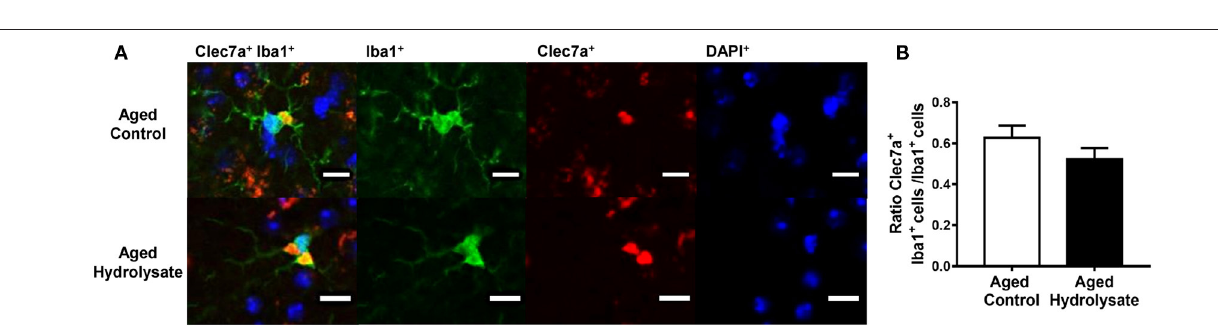
FIGURE 7 | Effects of the fish hydrolysate supplementation on Clec7a + Iba1 + /Iba1 + cells in the hippocampus. (A) Representative images of Clec7a + Iba1 + /Iba1 + cells (double staining), Iba1 + cells (in green), Clec7a + cells (in red) and DAPI + cells (in blue) (scale bars: 10 µ M) and (B) Number of positive cells for Clec7a and Iba1 staining in the hippocampus of aged mice fed with the control diet or the hydrolysate-enriched diet for 10 weeks ( n = 8 per group). Data are presented as mean ±